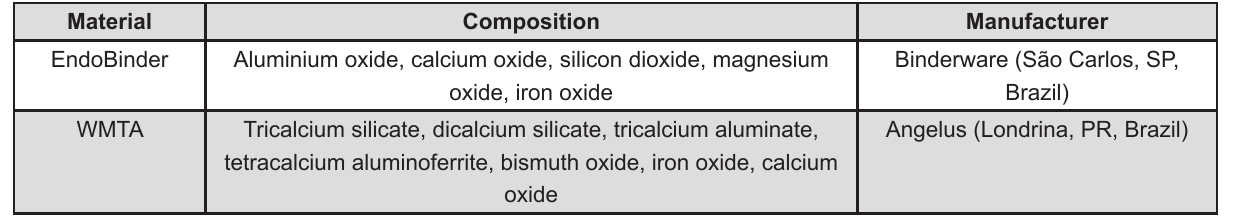
Figure 1- Materials tested and their